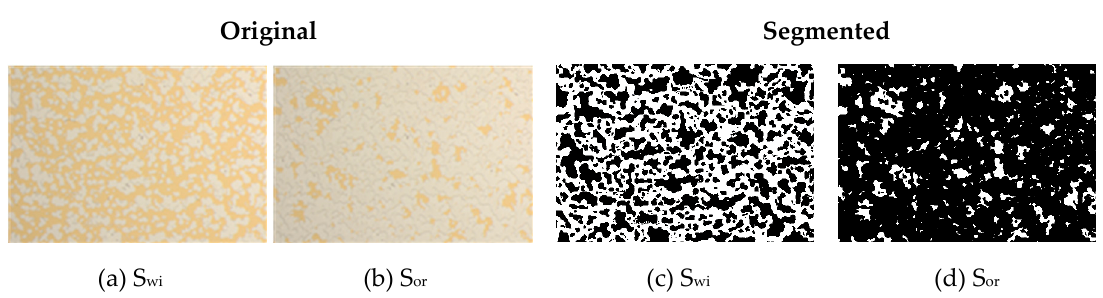
Figure 3. Original and segmented images of the pre- and post-flooding state in the microchip: ( a ) initial water saturation—original; ( b ) residual oil saturation—original; ( c ) initial water saturation—segmented; ( d ) residual oil saturation—segmented.